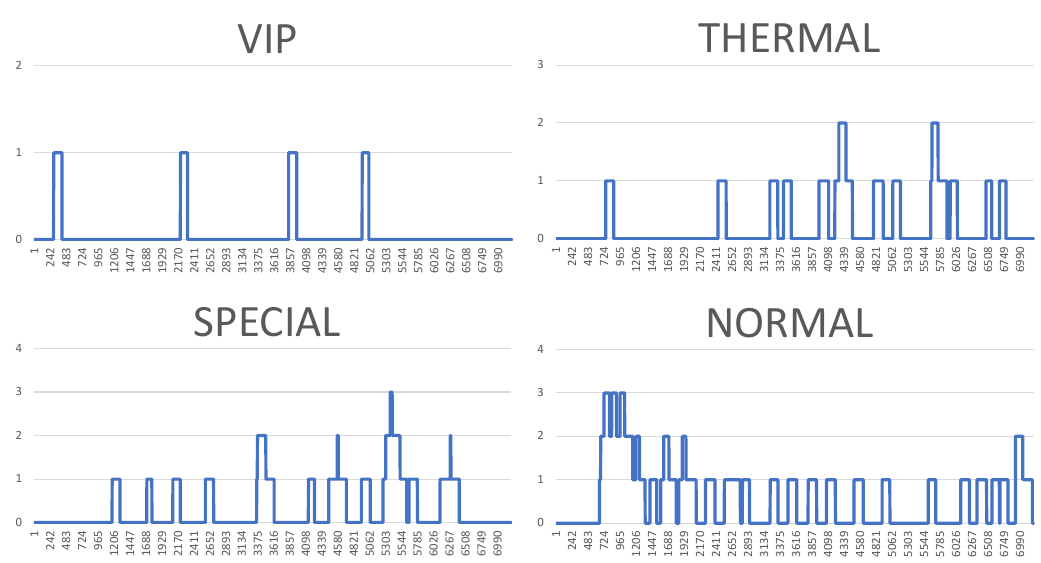
Figure 11. Results of the simulation processes carried out, or queue loads over the simulation time—medium mode. (Horizontal axes show the passing of simulation time from 0 to approx. 7000 s, vertical axes illustrate the current number of clients in particular queues.).